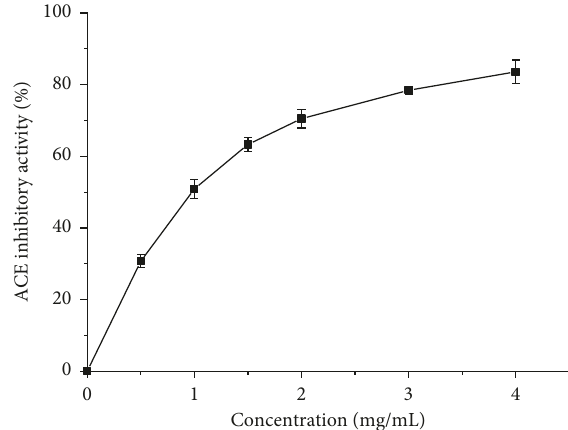
Figure 5: Effect on ACE-inhibitory activity. Data displayed as average ± standard deviations from three